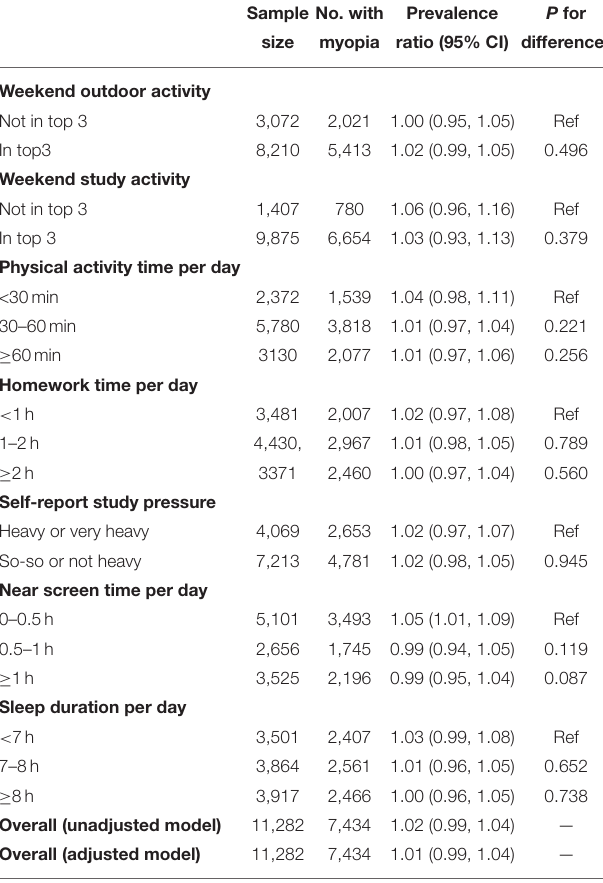
TABLE 4 | The association between myopia and spermarche status in boys from TABLE 3 | The association between menarche status and myopia in girls from the the paired sample in the 2014 CNSSCH, stratified by behavioral factors. paired sample in the 2014 CNSSCH, stratified by behavioral factors. Sample No. with Prevalence Sample No. with Prevalence